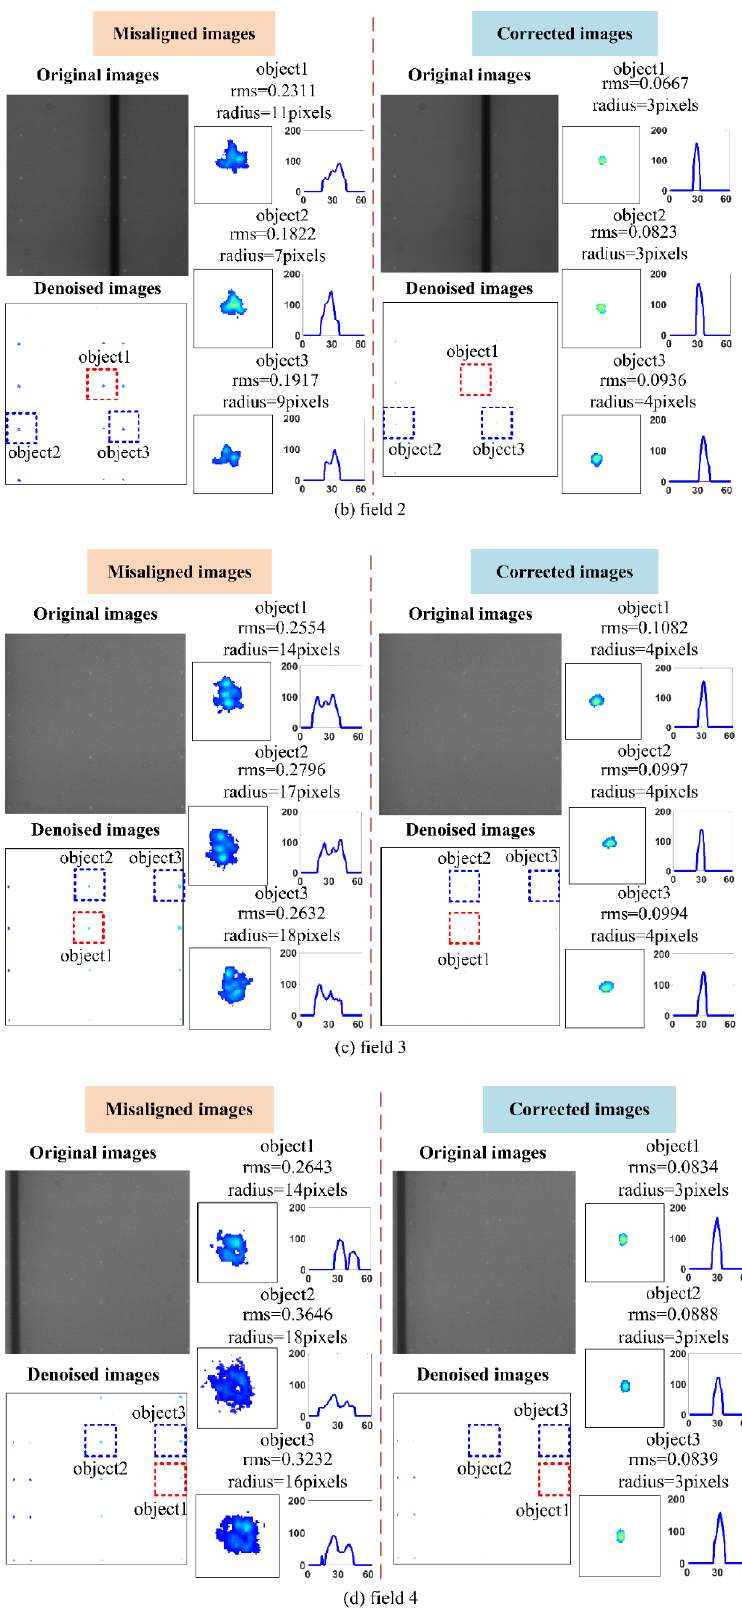
Figure 8. Misaligned and corrected images of ( a ) field 1, ( b ) field 2, ( c ) field 3, ( d ) and field 4.